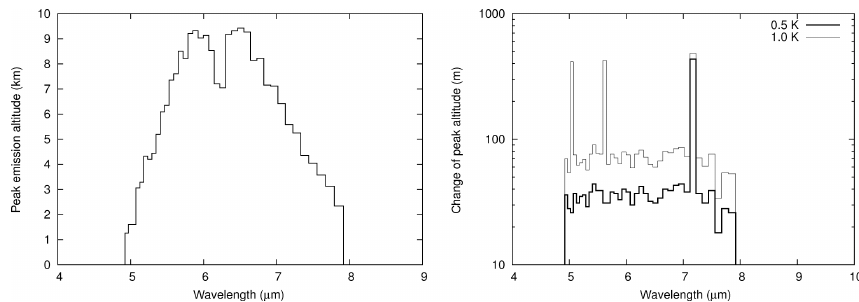
Figure 2. Left: peak altitude (in kilometres) for infrared emission to space (i.e. altitude where the optical depth reaches unity) as a function of wavelength (in micrometres) in the spectral region of the strong v 2 water vapour vibration–rotation band. The calculation has been done for a standard midlatitude summer atmosphere. Right: change of the peak altitude (in metres) after a climate warming of 0 . 5K (thick line) and 1K (thin line) throughout the troposphere (up to 12km) with constant relative humidity. The calculation has been performed for the midlatitude summer atmosphere and the same wavelength region as in the left panel.